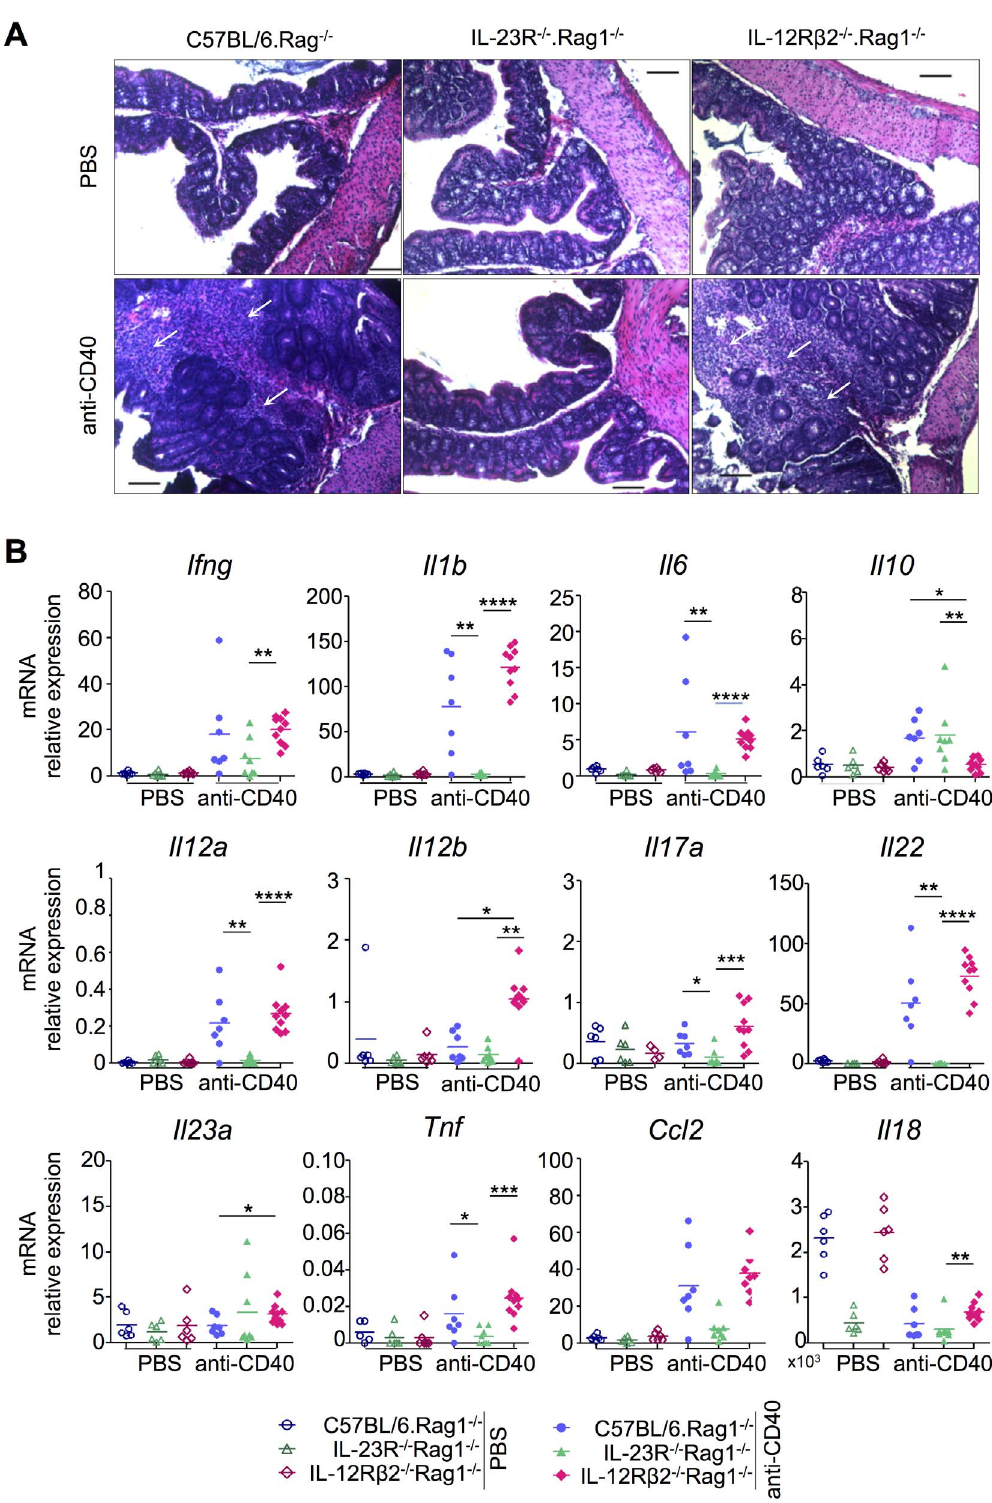
Figure 7. IL-23R + innate lymphocytes play a dominant role in the intestinal inflammatory response. (A) Histological examination of the colon. Increase in the thickness of the mucosa, inflammatory infiltration (indicated by arrows), goblet cell depletion, discrete glandular hyperplasia and edema of the submucosa were found in C57BL/6.Rag1 2 / 2 and IL-12R b 2 2 / 2 .Rag1 2 / 2 mice which received anti-CD40 antibody. Original magnification 100X. Scale=100 m m. (B) The relative mRNA transcription levels of cytokines and chemokines in the proximal colon are shown. Each symbol represents data for one mouse. * p , 0.05. ** p , 0.01. *** p , 0.001.